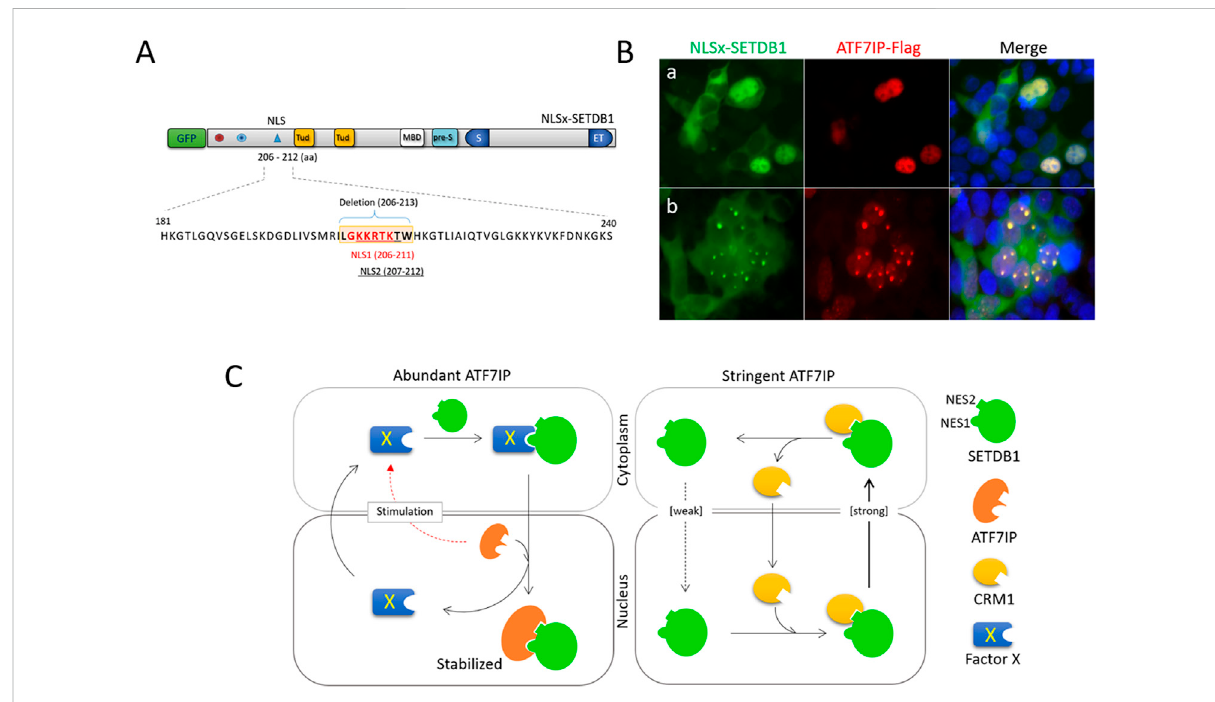
The NLS motif is dispensable for ATF7IP-stimulated movement of SETDB1 (A) Deletion of the NLS motif in GFP-SETDB1. Two almost overlapping NLS motifs (NLS1 in red and NLS2 underlined) in the SETDB1 N-terminus were deleted to generate NLSx-SETDB1 using